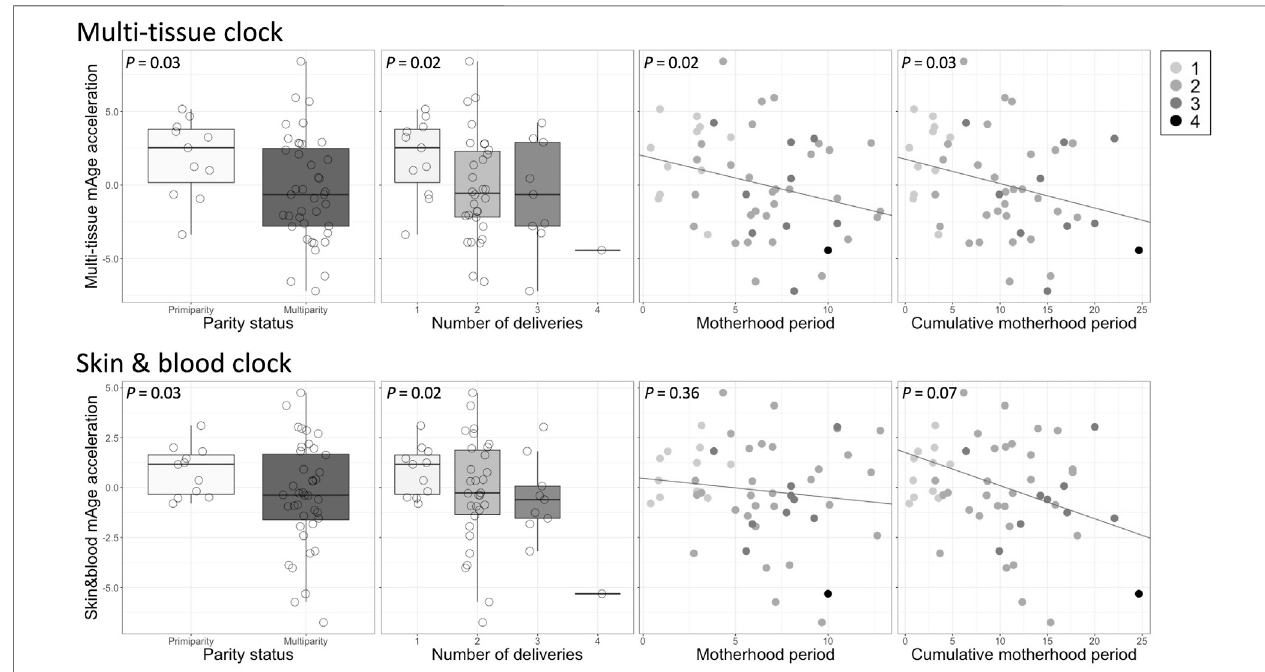
FIGURE 1 | Associations between each reproductive effort and mAge acceleration. Top: multi-tissue clock; bottom: skin & blood clock. The gray shading in the legend on the upper right re fl ects the number of deliveries.